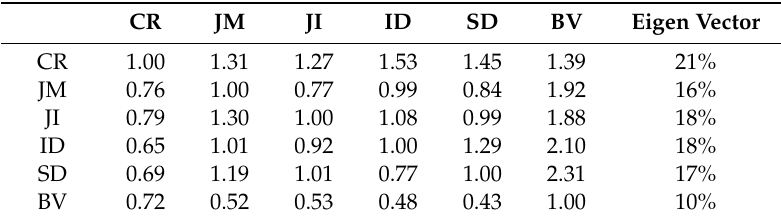
Table 8. Average pairwise comparisons and the Eigen vector for CMP culvert parameters.